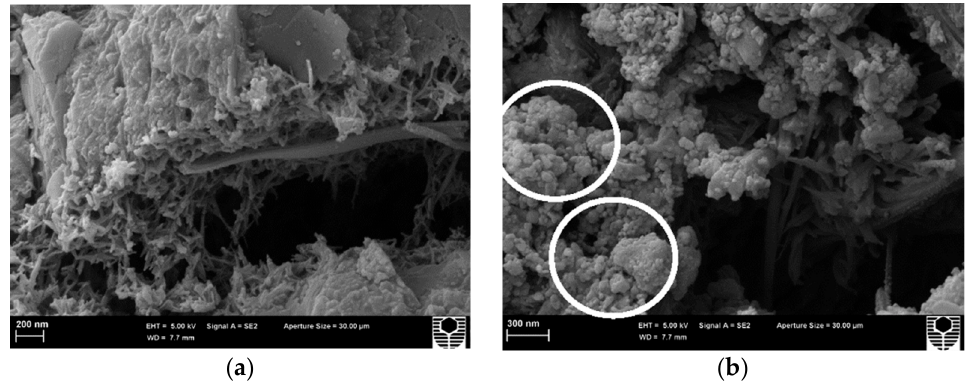
Figure 2. Microstructure SEM images of pastes ( a ) without nanoparticles and ( b ) with Al 2 O 3 nanoparticles acting as a filler (white circles) Reprinted/adapted with permission from [70]. 2023, Construction and Building Materials.